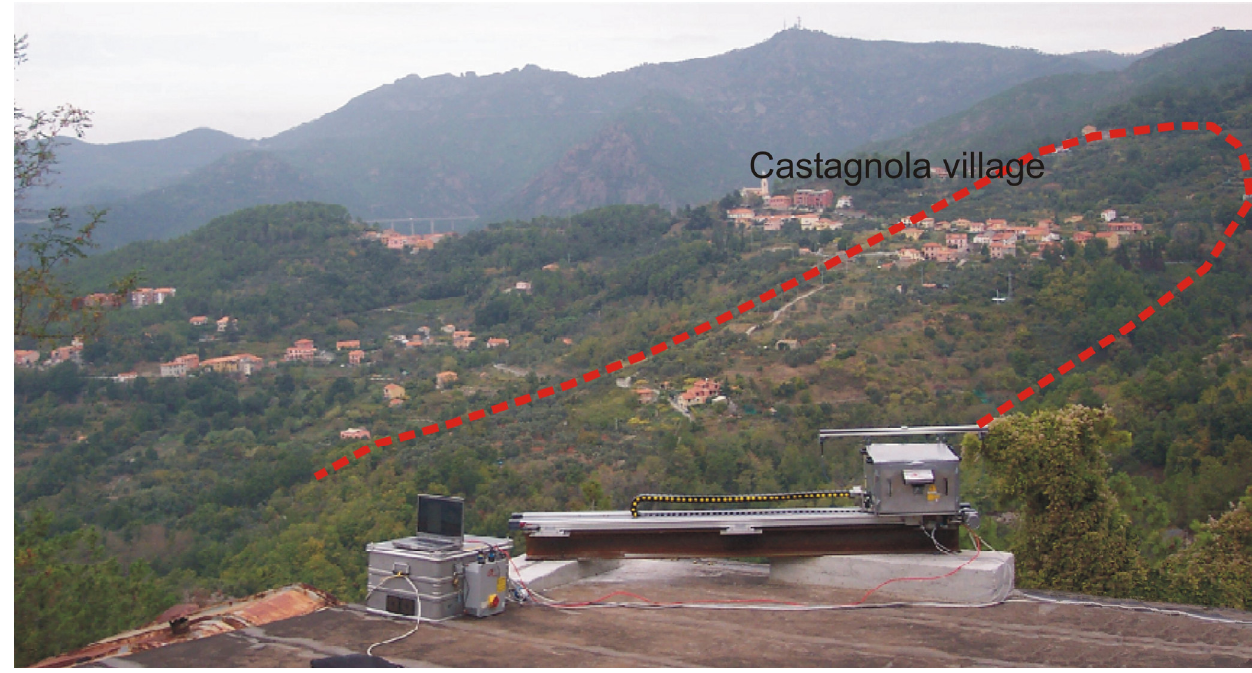
Figure 5. GBInSAR system used to monitor Castagnola landslide. The dotted line is the landslide perimeter.